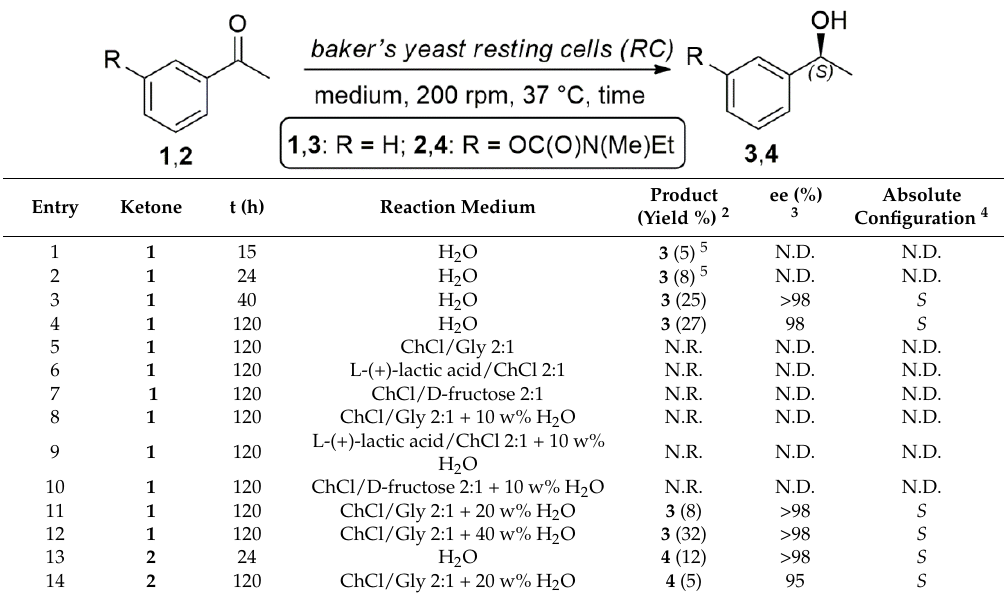
Table 1. Stereoselective bioreduction of ketones 1 and 2 with baker’s yeast RC in different reaction media. 1